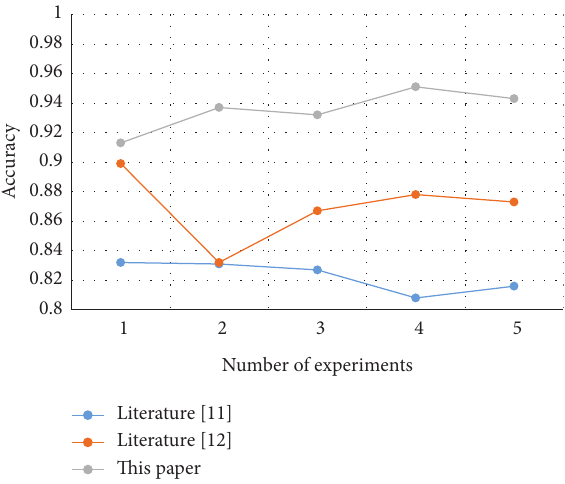
Figure 5: Accuracy of noisy music signals.